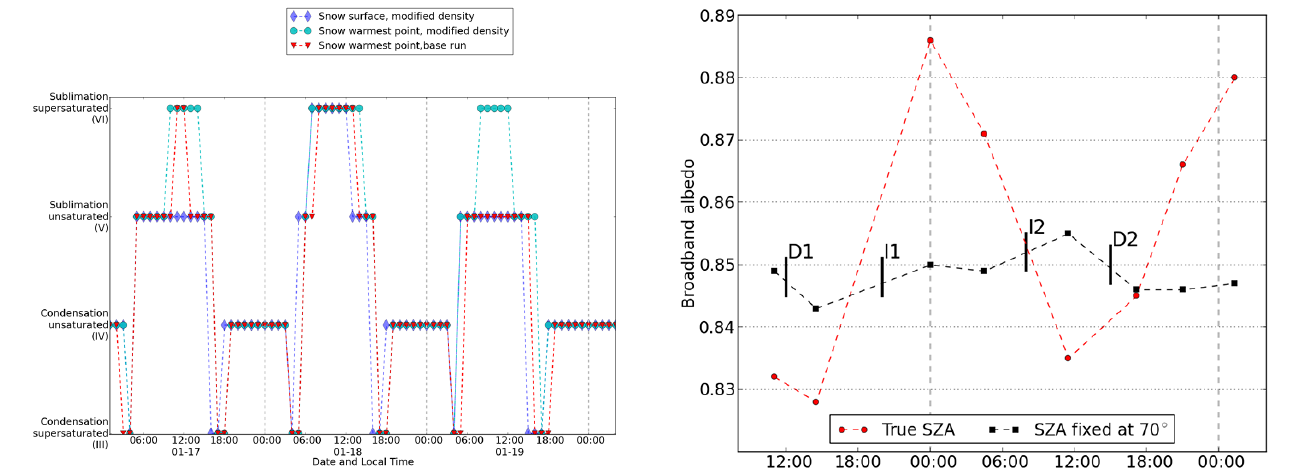
Figure 7. Determinations of the regimes of Style and Worster (2009) with modified density values and taking the snow temper- ature 1cm below the surface. The purple diamonds correspond to a simulation with modified density and where the snow temperature is taken as the surface temperature. The light blue circles are also for modified density but the snow temperature is taken 1cm below the surface. The red triangles are the results of simulations with mea- sured density and snow temperature from 1cm below the surface. Date is indicated in the lowest part of the x axis and local time just above.